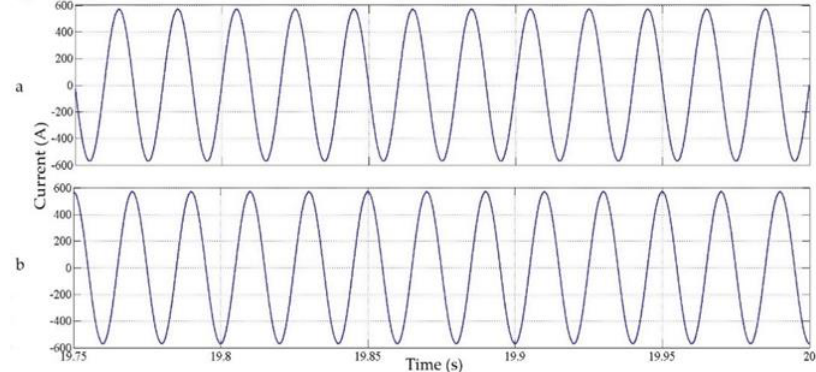
Figure 11. Transformed voltages ( a ) v α ; ( b ) v β .